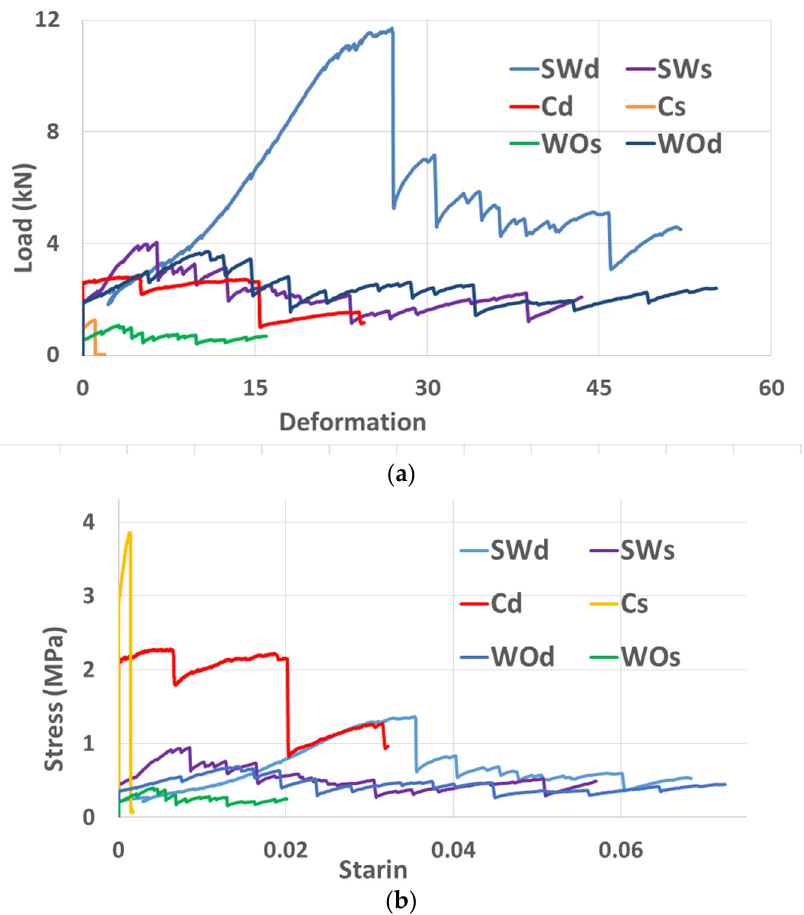
Figure 7. ( a ) Load–displacement and ( b ) stress–strain curves of all tested structural elements.